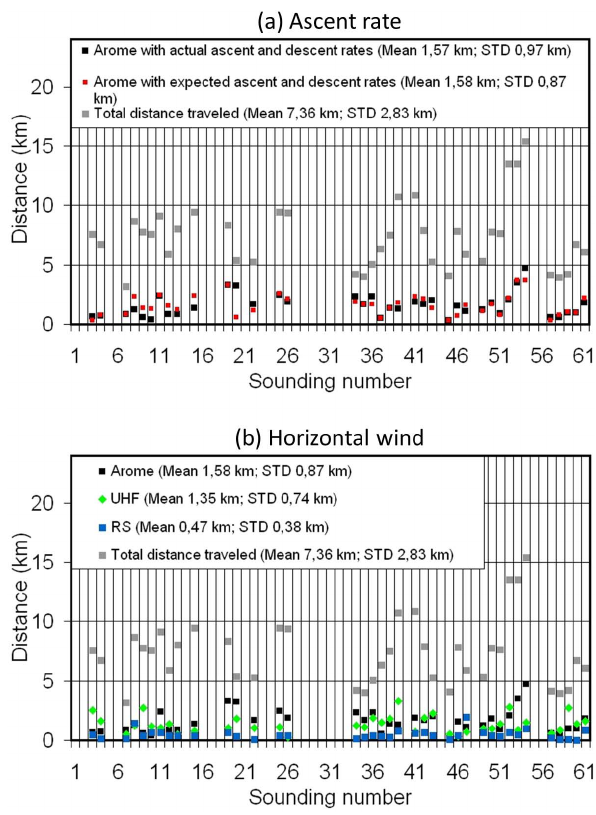
Fig. 7. Difference between actual and simulated radiosonde falling points as a function of (a) ascent rates and (b) horizontal wind pro- files used to simulate the trajectories. Scores are computed for re- covered balloons only.